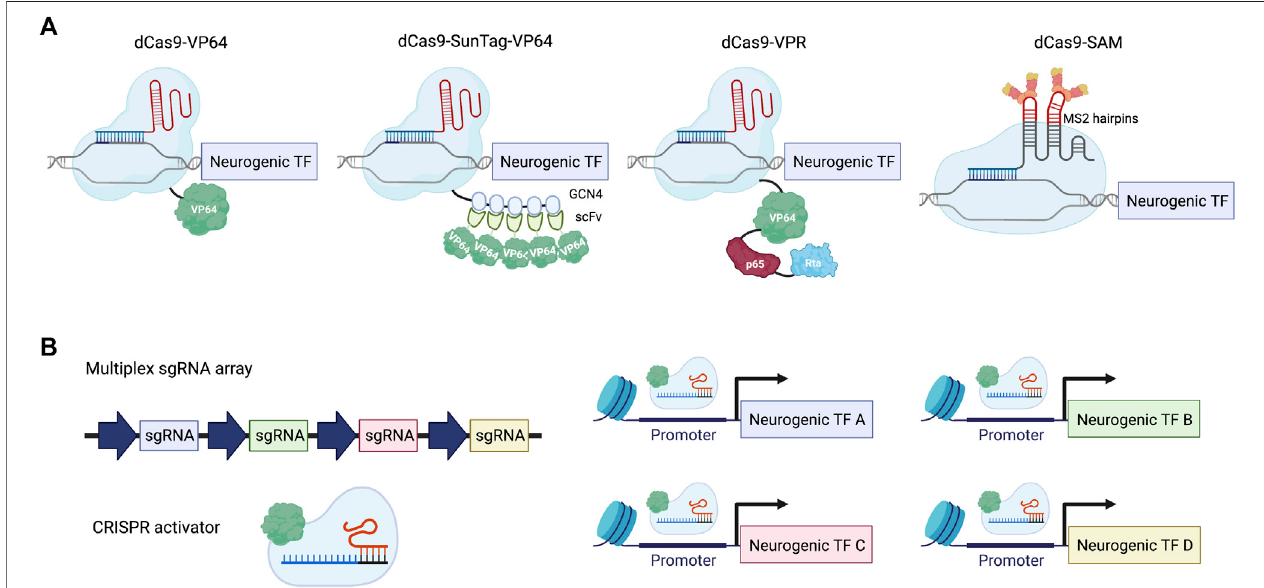
FIGURE 1 | Neuronal differentiation using CRISPRa. (A) Examples of the CRISPRa system. dCas9-VP64: dCas9 tagged with a single copy of VP64 activation domain;dCas9-SunTag-VP64:dCas9taggedwithatandemrepeatofGCN4peptide,whichrecruitsmultiplecopiesofVP64throughscFvbinding;dCas9-VPR:dCas9 fused with a combination of activator domains: VP64, p65 and Rta; dCas9-SAM: gRNA is linked with two copies of the MS2 coat protein binding-RNA stem loop to recruit MS2-VP64 for gene activation. (B) Scheme illustrating multiplexed activation of neurogenic transcription factors (TFs) using CRISPRa.